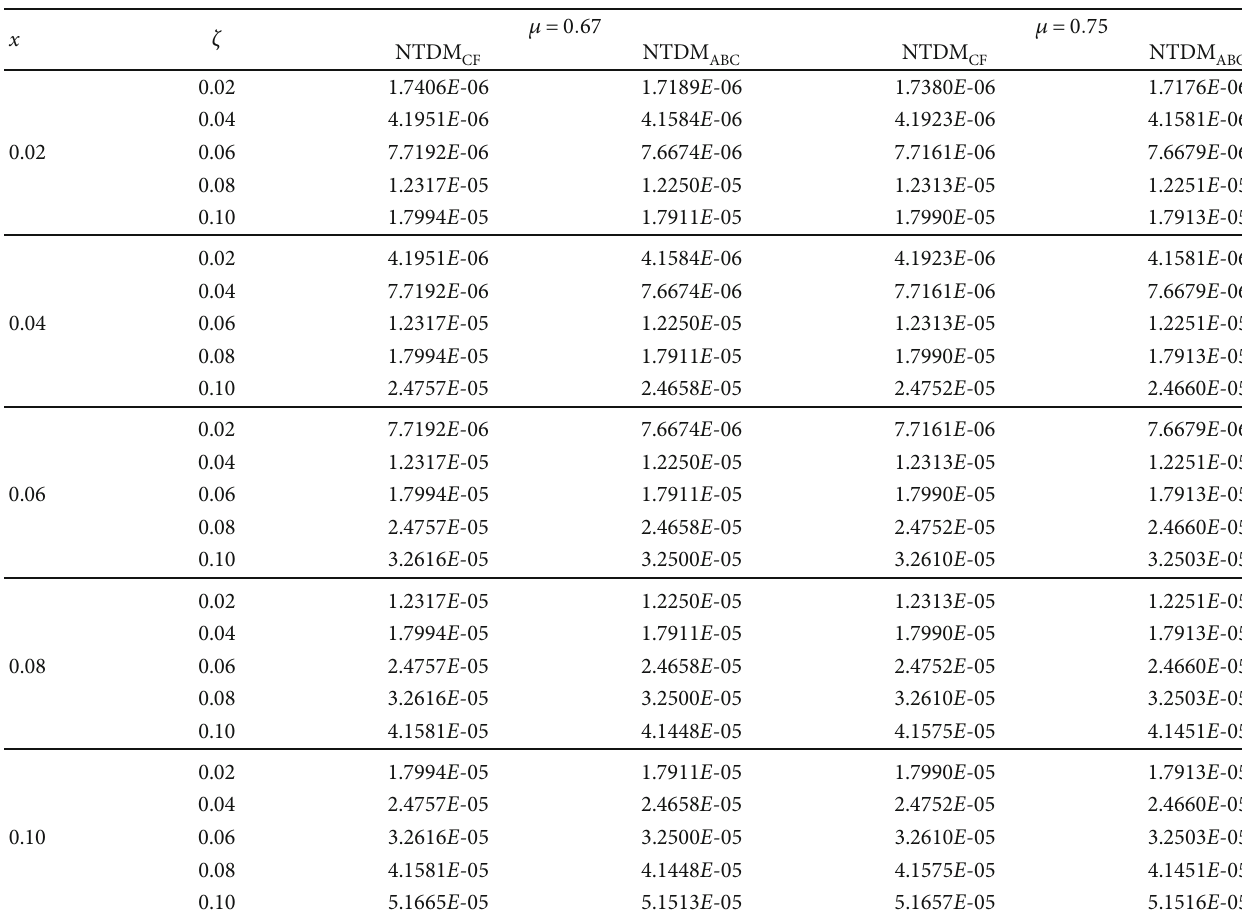
NTDM μ = 0 : 67 and μ = 0 : 75 of Example 1 for t = 1 and λ = 0 : 001 . CF and ABC for